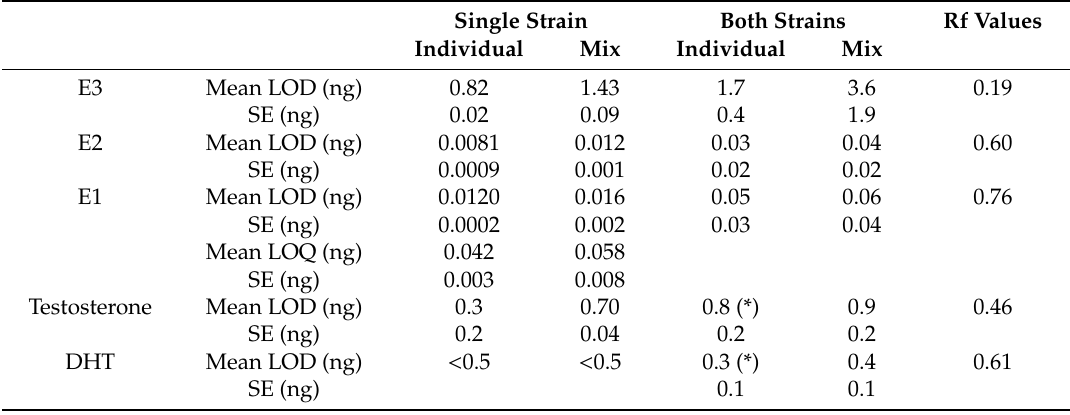
Table 2. Limit of detection (LOD), limit of quantification (LOQ) and Rf values calculated for the ER–Ruby and AR-BFP sensor strains in response to HPTLC-separated reference compounds. Single Strain Both Strains Rf Values Individual Mix